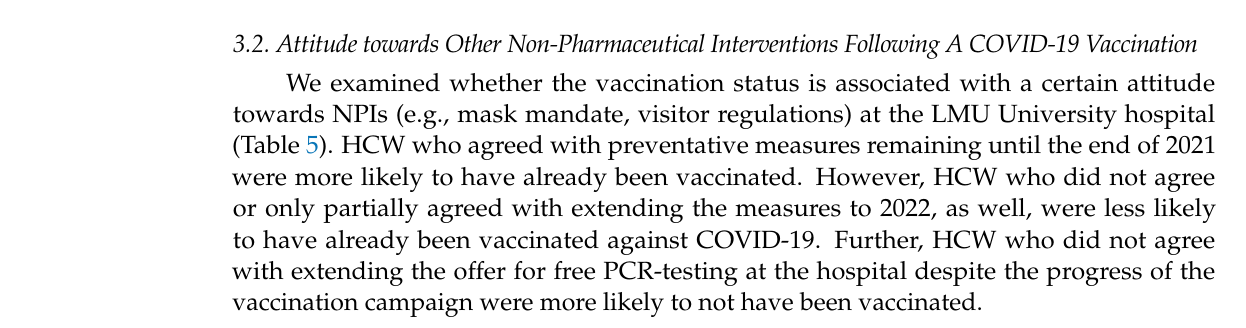
Table 5. Binomial logistic regression of negative COVID-19 vaccination status associated with the attitudes towards other implemented non-pharmaceutical